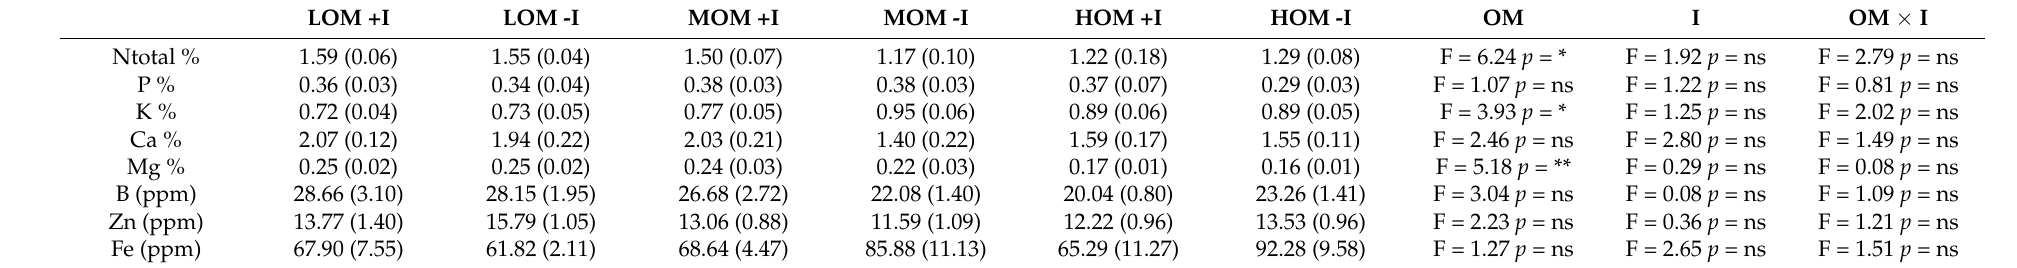
Table 2. Mean values ( ± SE) of foliar nutrient concentrations at various treatments. +I and -I refer to irrigation and non-irrigation; OM: organic matter. (ANOVA, ns: non-significant; *: p ≤ 0.05; **: p ≤